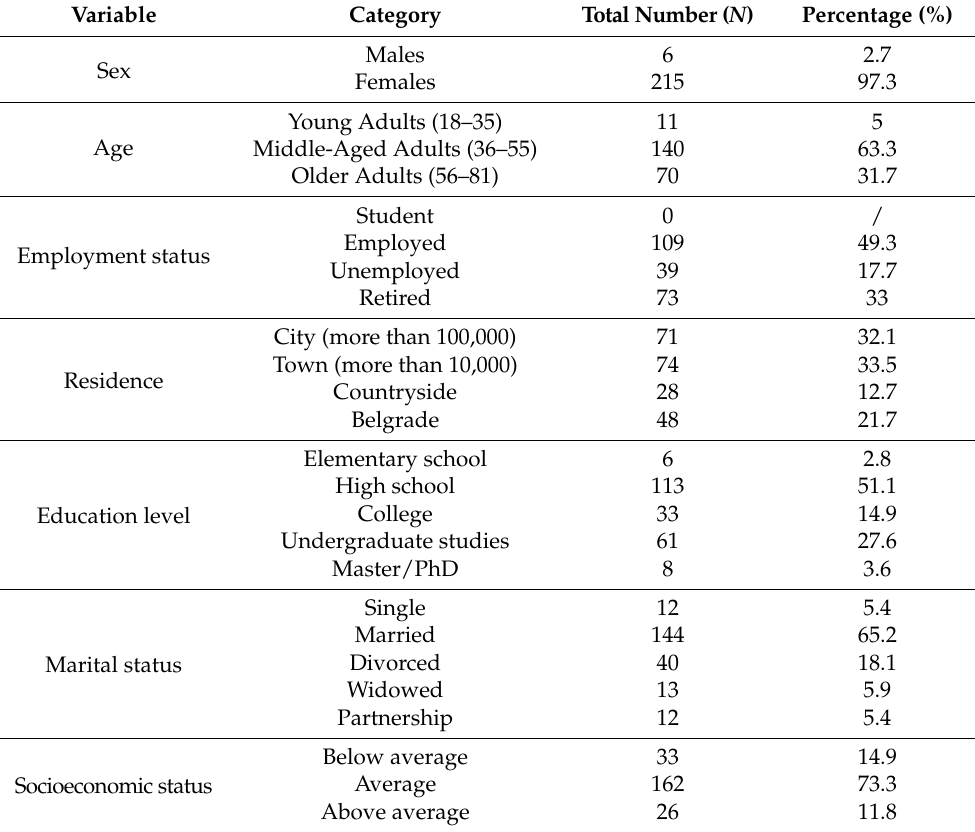
Table 1. Sociodemographic characteristics of study